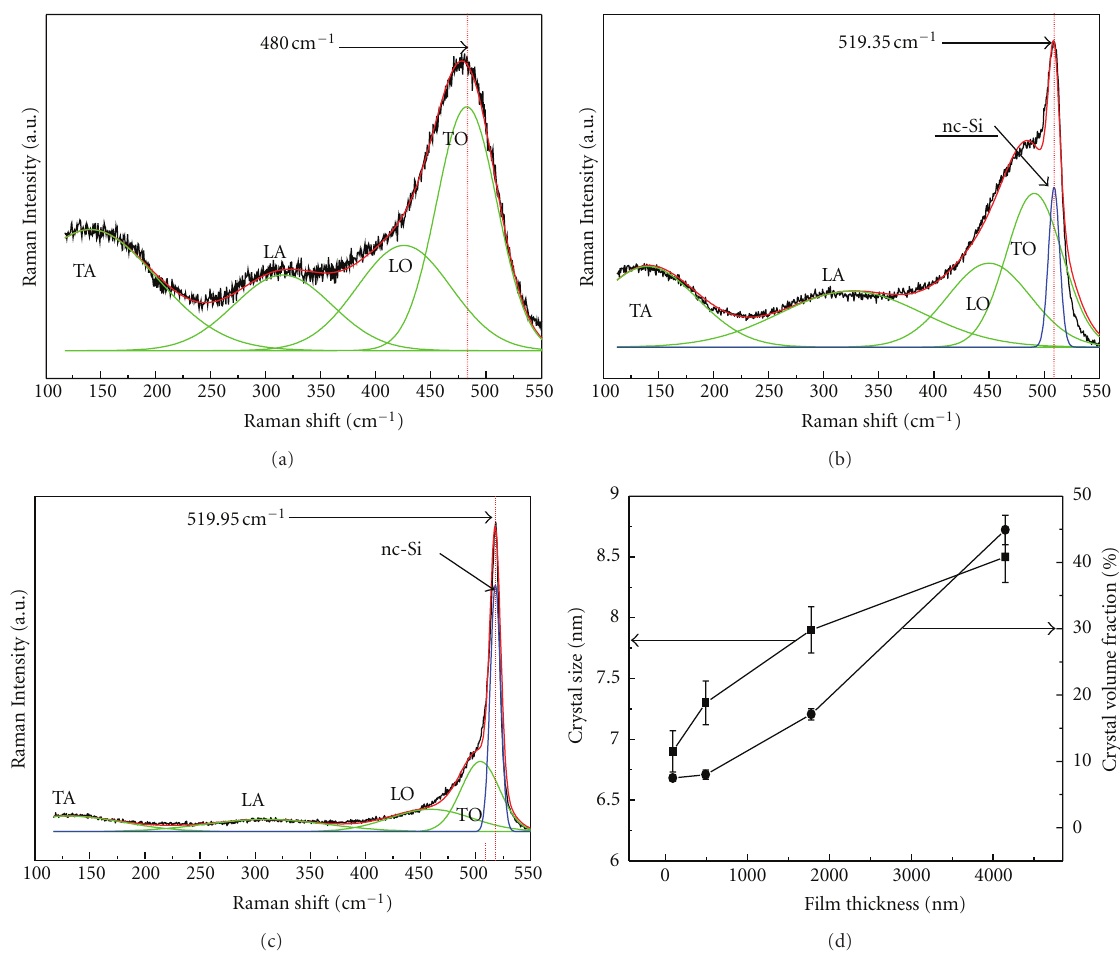
Figure 3: Raman spectra of the films. The best fits are superimposed in each spectrum. The films were deposited for (a) 10, (b) 180, and (c) 360min. (d) Crystal size and volume fraction versus film